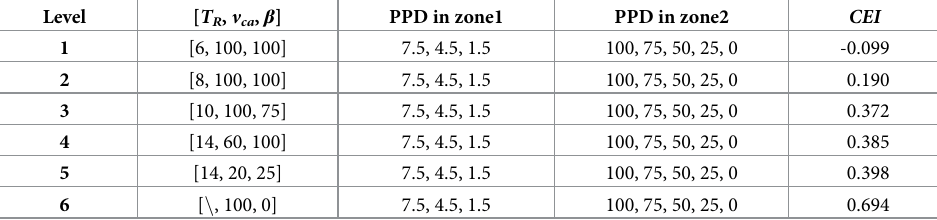
Table 3. The typical scenarios for different thermal environment levels.